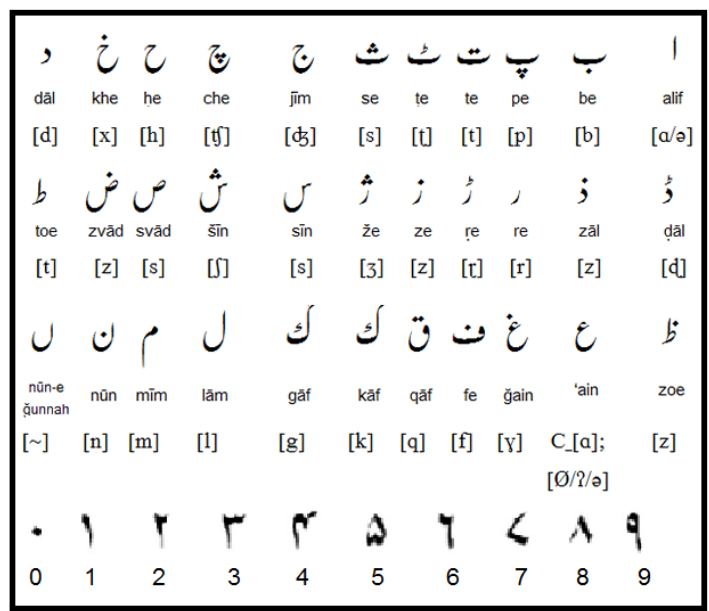
Figure 1. Urdu character set with phonemes and numerals with their Roman